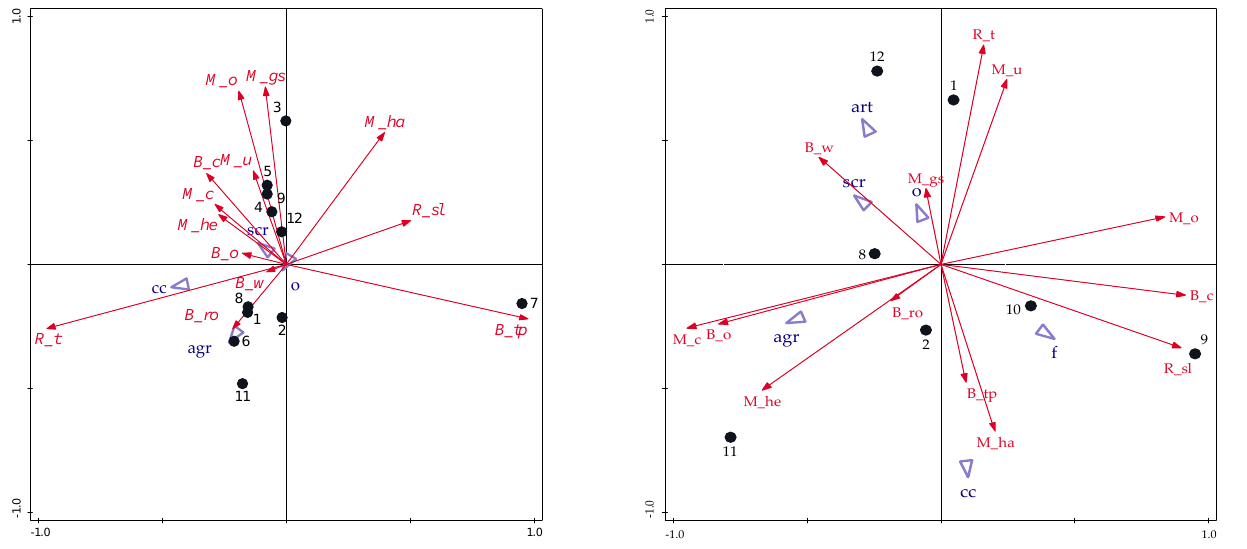
Figure 3. PCA triplot for breeding ( left ) and non-breeding ( right ) seasons, showing the position of territories (dots), environmental parameters (triangles) on ridges at 6.5 km around nests and prey categories (red arrows). agr: agricultural land, cc: canopy cover, scr: scrub and o: open land. Prey categories codified as in Table 1.